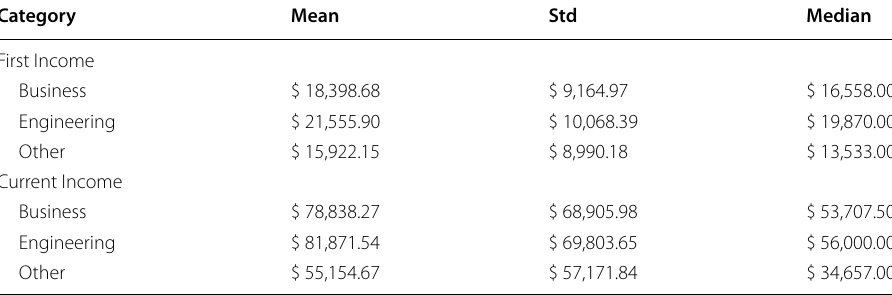
Table 3 First Income and Current Income median, mean, and standard deviation statistics by School